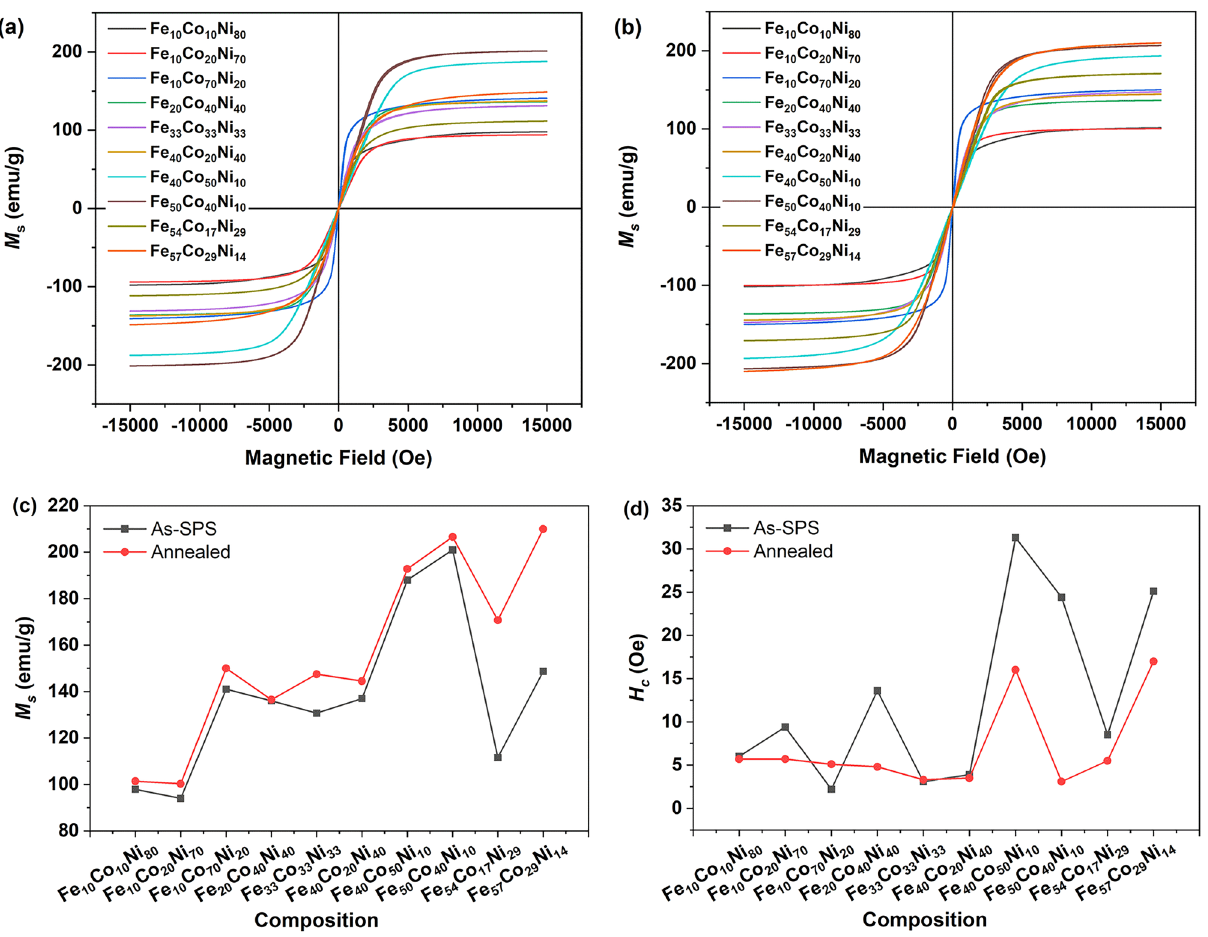
Figure 4. Field dependence of magnetization at room temperature for ( a ) as-SPS and ( b ) annealed samples, ( c ) variation of M s with composition and ( d ) H c as a function of composition for as-SPS and annealed ternary alloys.